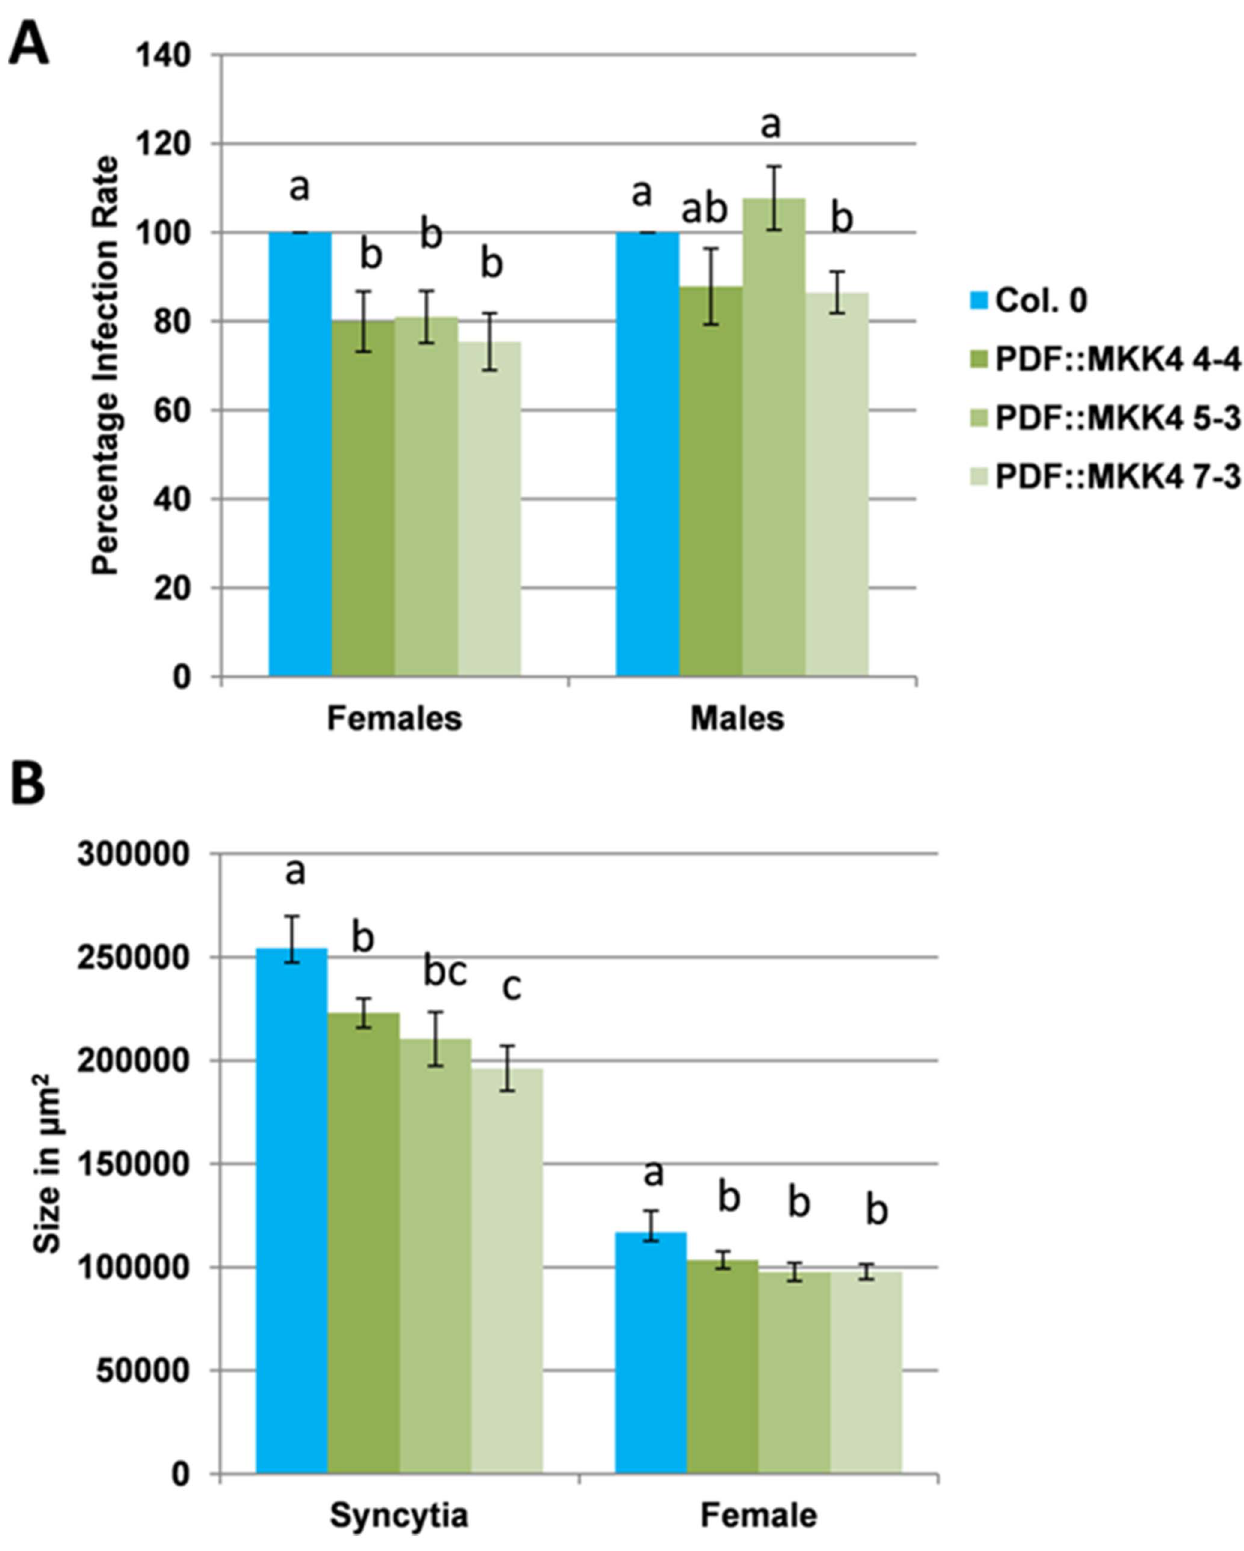
Figure 8. Nematode resistance test for MKK4 DD overexpression lines. The resistance of MKK4 DD lines was compared to wild type plants after infection with H. schachtii . A: Number of male and female nemaodes per cm of root length calculated at 15 dpi setting the wild type as 100%. Different letters indicate significant differences (P , 0.05; ANOVA and LSD). The statistical significance was determined by three independent replicates. Values are means 6 SE, n=15. The bar shows standard error for the mean. B: Size of female syncytia and female nematodes at 14 dpi. Ten syncytia were selected randomly from three independent replicates (total=30) and the size of syncytia and associated female nematodes was determined. Data were analysed for significance difference using ANOVA (P , 0.05) and LSD. Values are means 6 SE. doi:10.1371/journal.pone.0102360.g008 PLOS ONE |